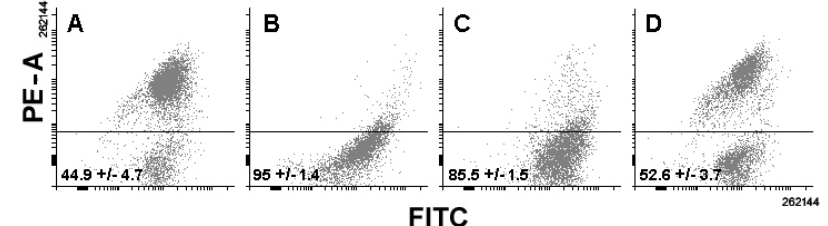
Figure 4. Representative flow cytometric analyses of the MMP in untreated ( A ), valinomycin- (( B ); 1 µ M), crude extract- (( C ); 9.16 µ g / mL), and 10K fraction-treated (( D ); 8.34 µ g / mL) MDA-MB231 cells for 48 h. The x - and y -axes report the intensities of green and red fluorescence emitted by JC-1 in physiologic or depolarization conditions, respectively. The ionophore valinomycin was used as a positive control to dissipate MMP. The values indicated in the bottom quadrants in each frame correspond to the percentage of low red fluorescence-emitting events attributable to cells that underwent dissipation of MMP. The data are expressed as mean ± s.e.m. of three independent